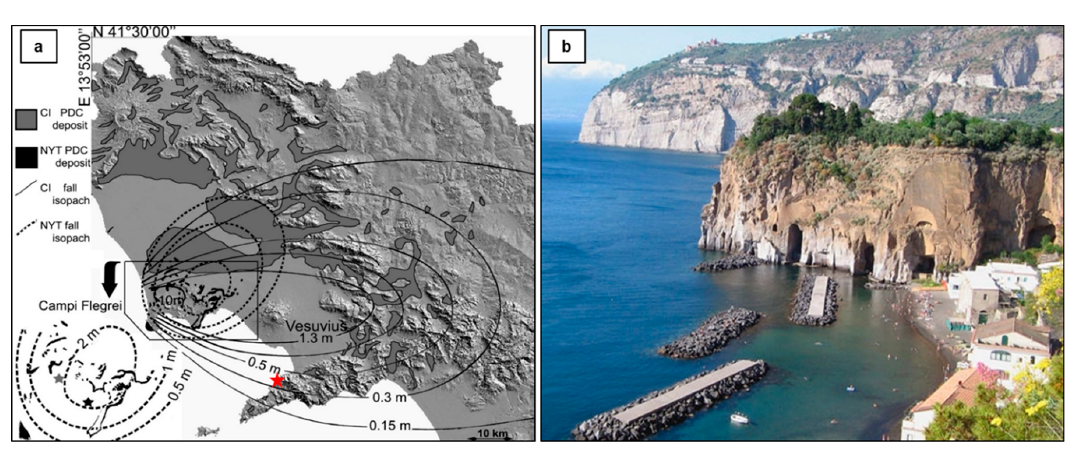
Figure 11. ( a ) distribution of Campanian Ignimbrite (CI) and Neapolitan Yellow Tuff (NYT) pyroclastic density current (PDC) deposits and fall deposits (modified after Scarpati, and Perrotta, [40]). Inset (left) shows their source area ( Campi Flegre i) and presumed vent locations (black star—NYT vent; gray star—CI vent; red star— Villa del Pezzolo location); ( b ) CI-WGI cliff, Piano di Sorrento.